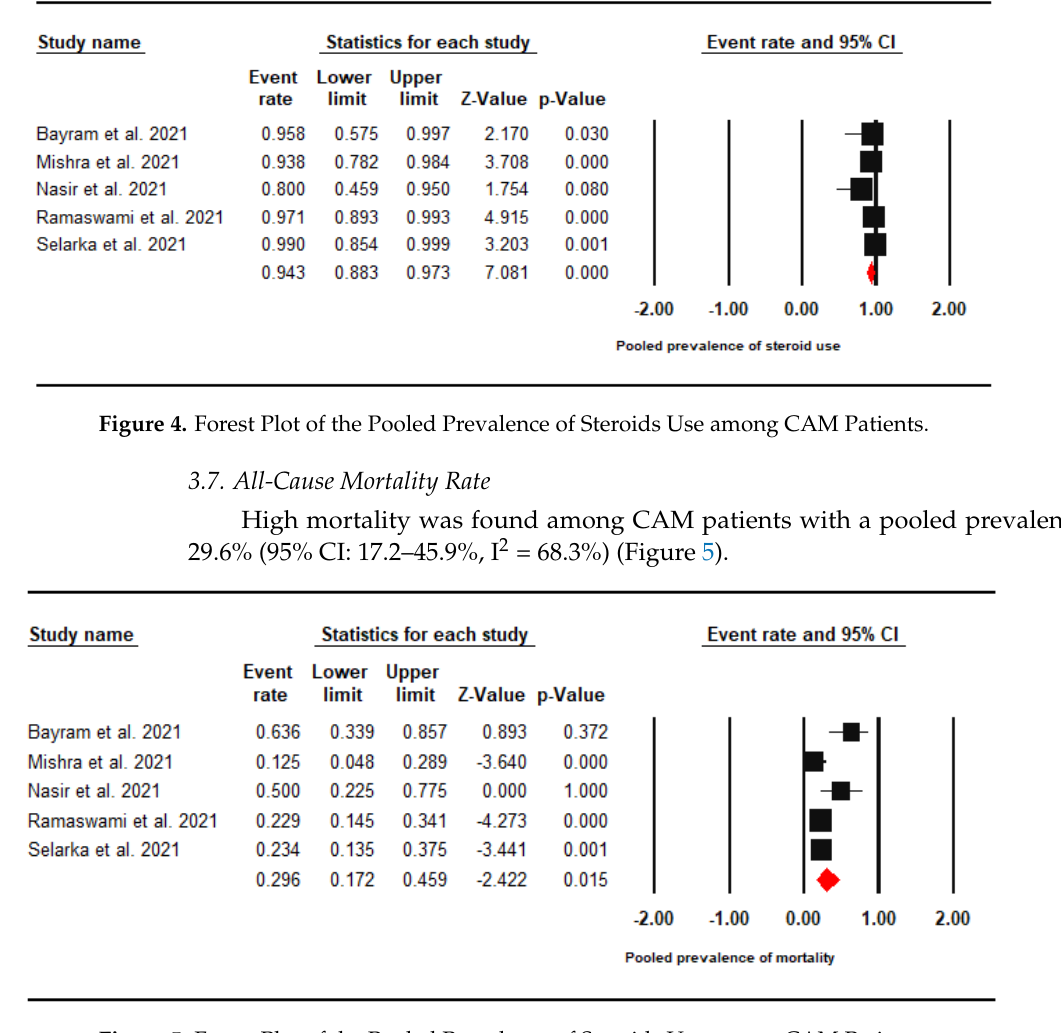
Figure 5. Forest Plot of the Pooled Prevalence of Steroids Use among CAM Patients.